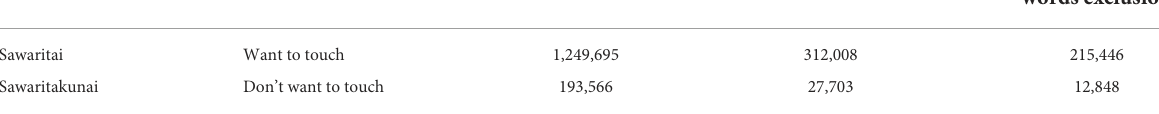
Number of with target words after noisy target words exclusion